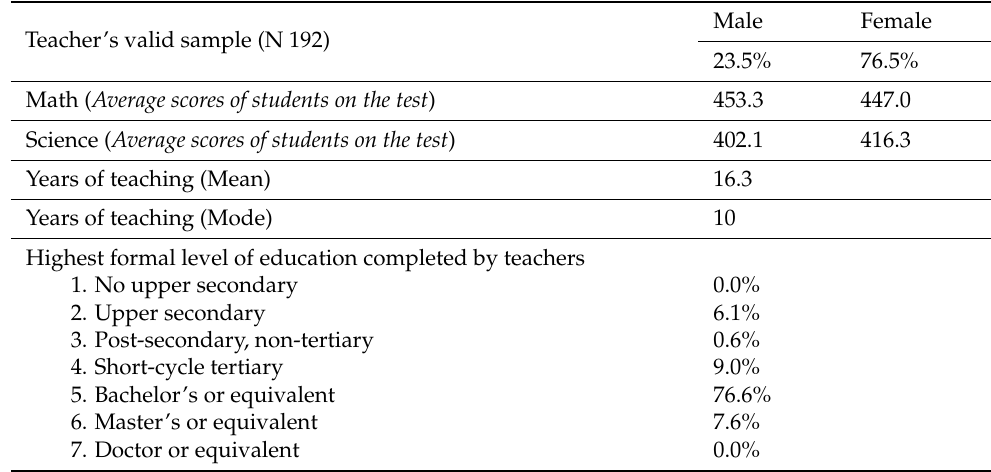
Table 1. Teacher demographic data cross-referenced with student test